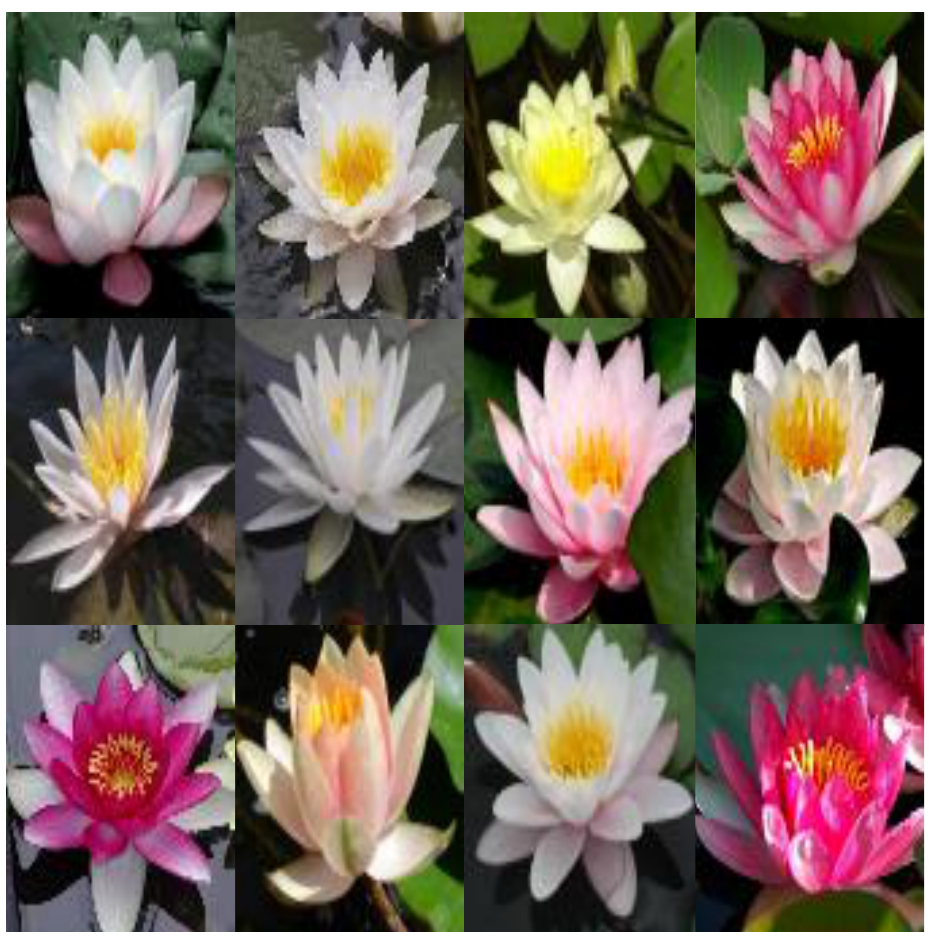
Figure 7. The Oxford-102